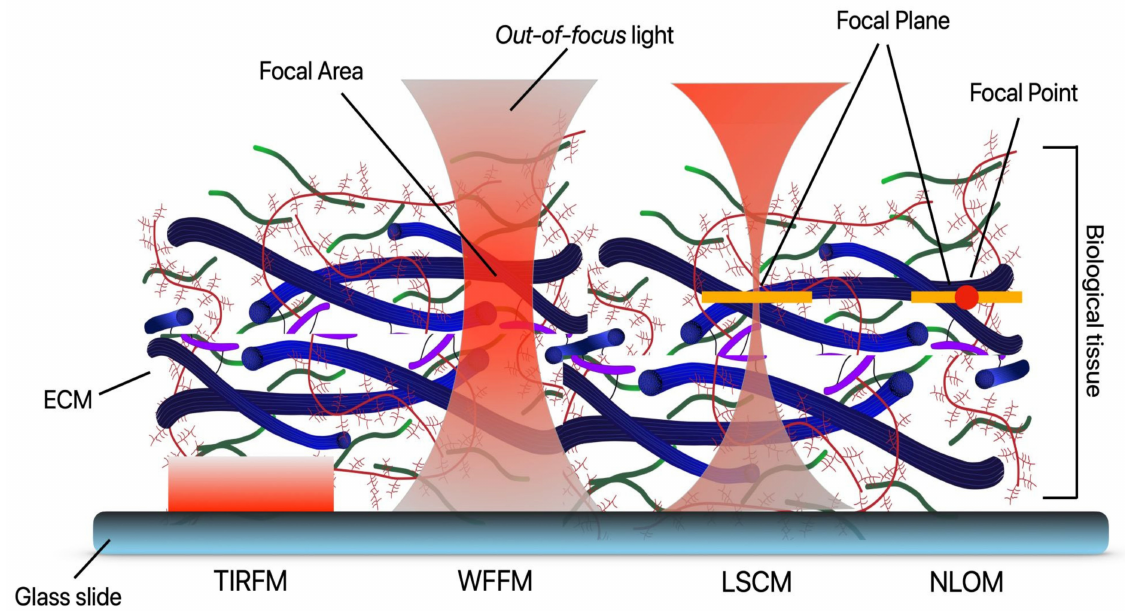
Figure 6. Schematic comparison of the most common optical microscopy modalities. TIRFM presents good SNR due to the low penetration depth of the evanescent field. WFFM is very versatile but tends to present a significant background signal. LSCM provides an improvement over WFFM by reducing the background detection and keeping its versatility. NLOM modalities only generate a significant signal on a specific focal point and have spatial resolution inferior to the so-called super-resolution modalities (e.g., SIM, STED, STORM, PALM). TIRF: total internal reflection fluorescence microscopy; WFFM: widefield fluorescence microscopy; LSCM: laser scanning confocal microscopy. NLOM: nonlinear optical